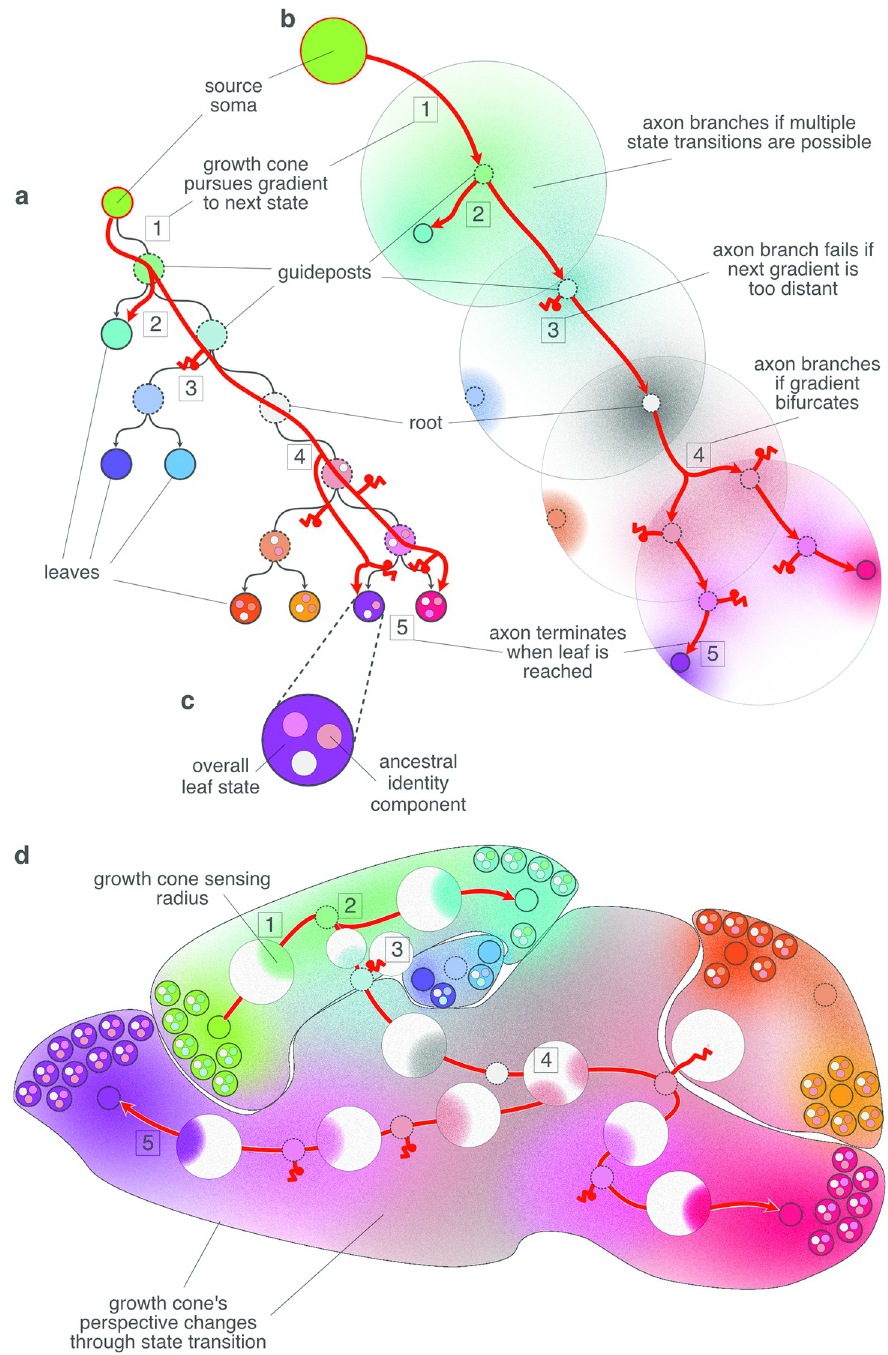
Fig 4. Navigation of an axon (red branching arrow) through the familial address space. Throughout the figure, similarity in color denotes similarity in gene expression profile. A The axon traverses the brain by traversing a sequence of familial states of the lineage tree that is implicit in its genome. The growth cone uses the sequence of familial states as successive search templates in brain space, and so navigates from a source leaf node to a number of target leaves. Familial states (colored circles) correspond to nodes of the encoded lineage tree. For purpose of explanation, the tree is hung from the leaf state corresponding to the axon’s source neuron, rather than from its root node as in Fig 3b. Terminal states of leaf (existent) nodes have a solid circumference, while ancestral states in the interior of the tree have a dotted circumference. Transitions between states occur downward, along the arrowed arcs, beginning at the source leaf (red encircled) and ending at (some) other leaves. The original tree root can be